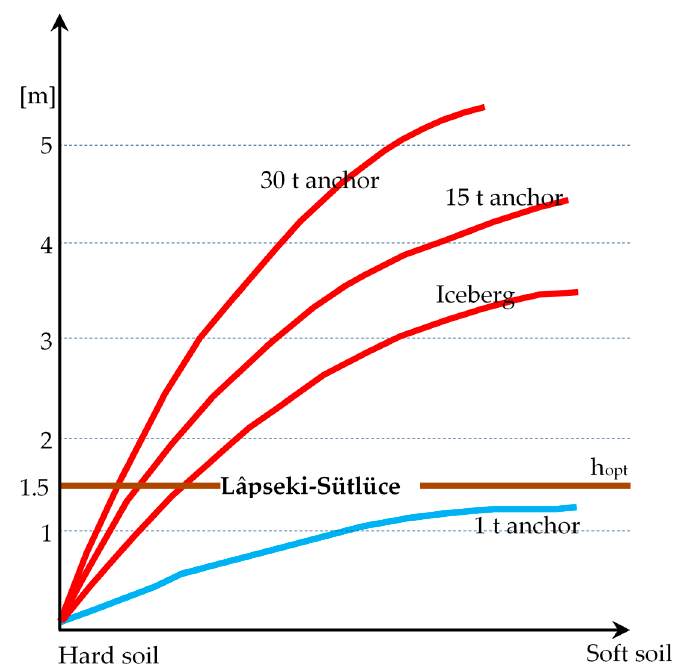
Figure 8. Anchor penetration versus soil hardness.